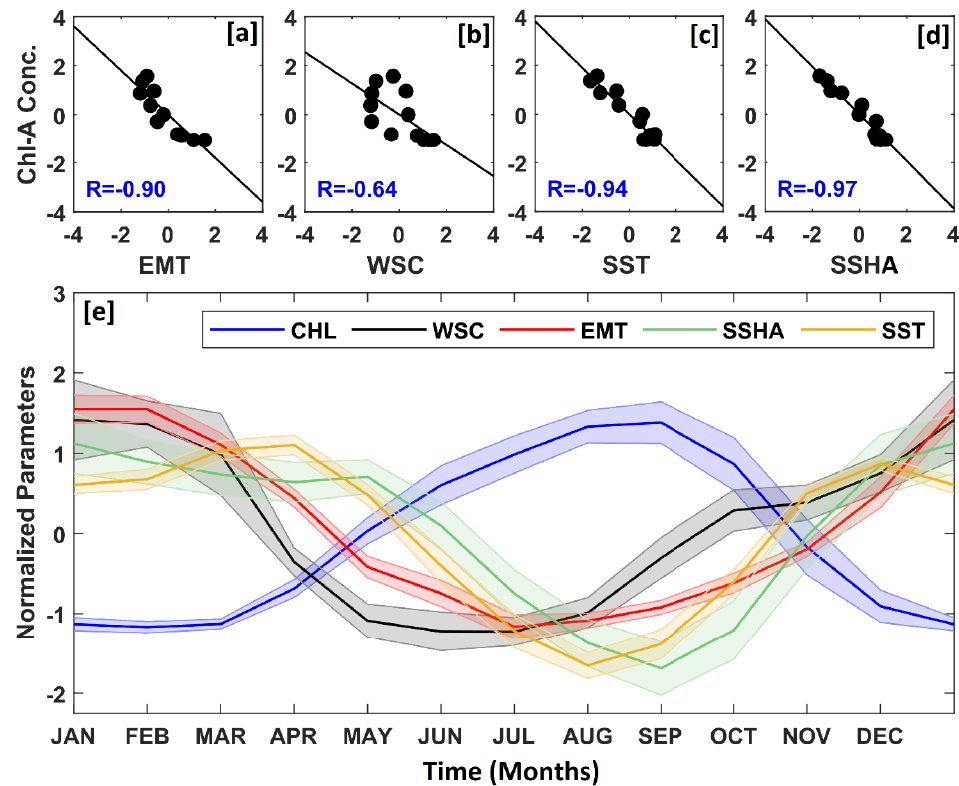
Figure 5. Comparison of climatological monthly chlorophyll-a concentration (CHL) with ( b ) sea surface height anomaly (SSHA), ( c ) sea surface temperature (SST), ( d ) Ekman mass transport (EMT) and ( e ) wind stress curl (WSC). All the parameters are seasonally averaged during 2008−2019 and then normalized for better comparison. The black line represents the best fit line. ( a ) Seasonal evolution of these normalized EMT, WSC, SST, SSHA and CHL. The shaded background of each of the time series indicates the standard error of its mean.